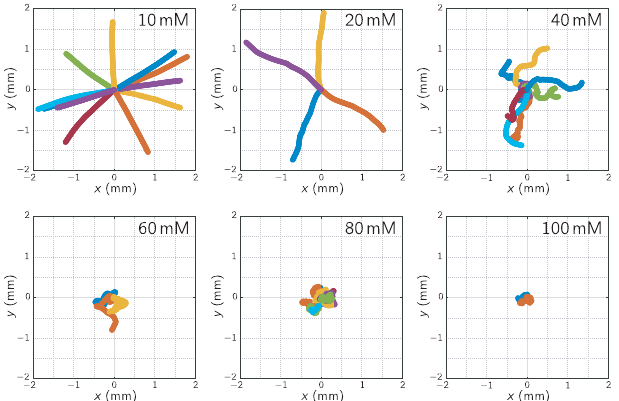
FIG. 2. Individual trajectories of 30 μ m diameter droplets, lasting 4 s, swimming in aqueous solutions with increasing bulk SDS concentrations. The motion transitions from ballistic to diffusive, with more frequent turns leading to a slower explora- tion of space, which is still orders of magnitude higher than that of thermal rotational